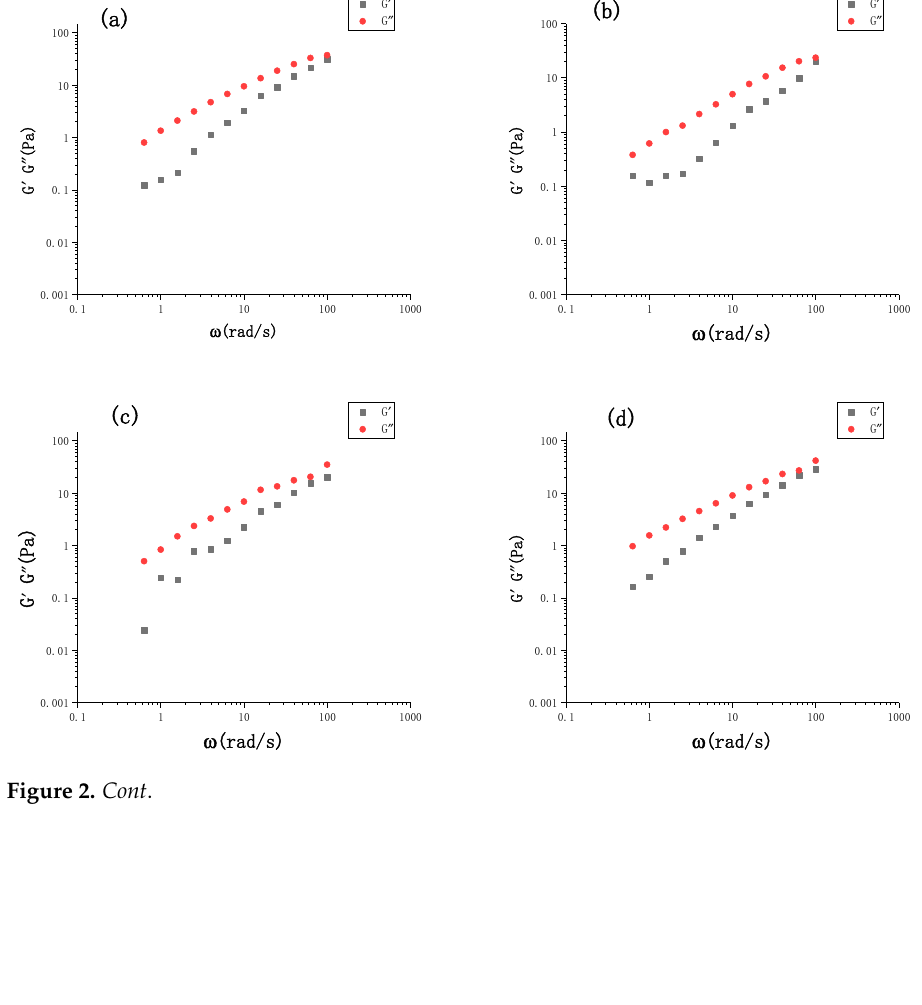
5 of 17 Figure 1. The drying kinetics curves of S0–S3 film-forming solutions. It was also observed that all curves had three stages during the drying process. The same result was described as the latex film-forming solution by Löfflath and Gebhard [23]. In the first stage, the rates of water evaporation of all samples were constant. Water con- tents of all film-forming solutions decreased linearly and evenly. When the water contents